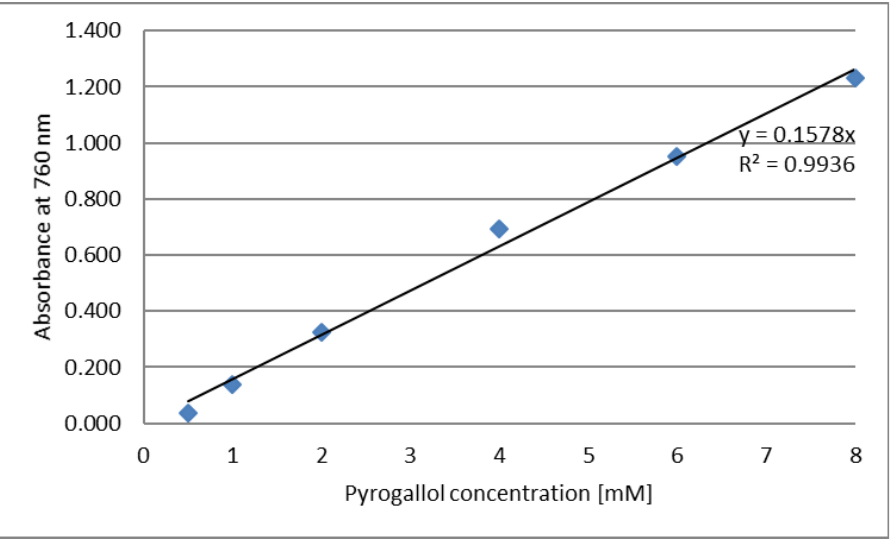
Figure 8. Calibration curve—absorbance dependence on pyrogallol concentration.